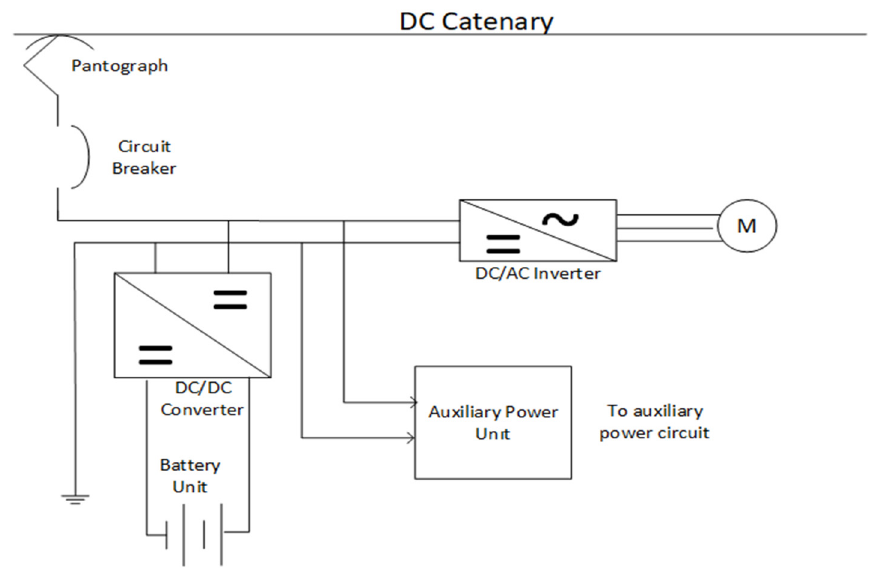
Figure 1. Electric with battery traction system